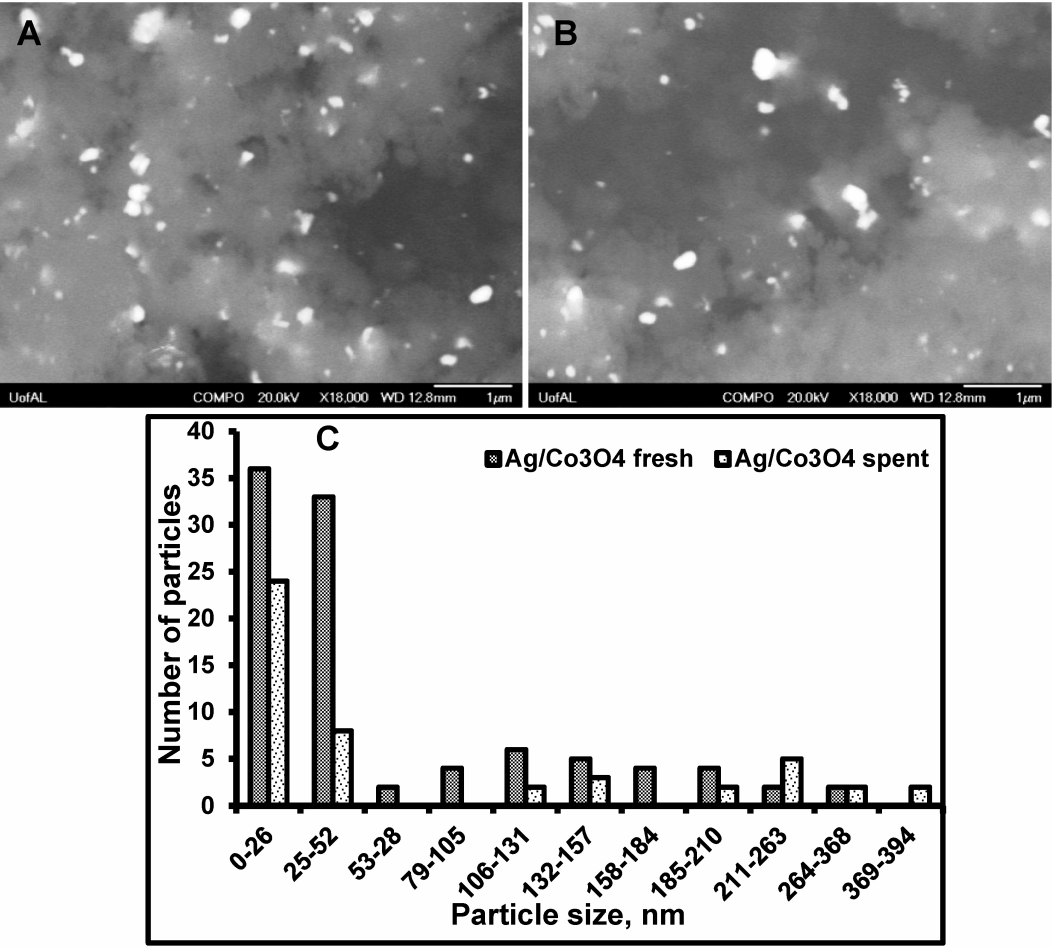
Figure 8. SEM particle size distributions of fresh ( A ) and spent ( B ) Ag/Co 3 O 4 monoliths; ( C ) particle size distribution of fresh and spent Ag/Co 3 O 4